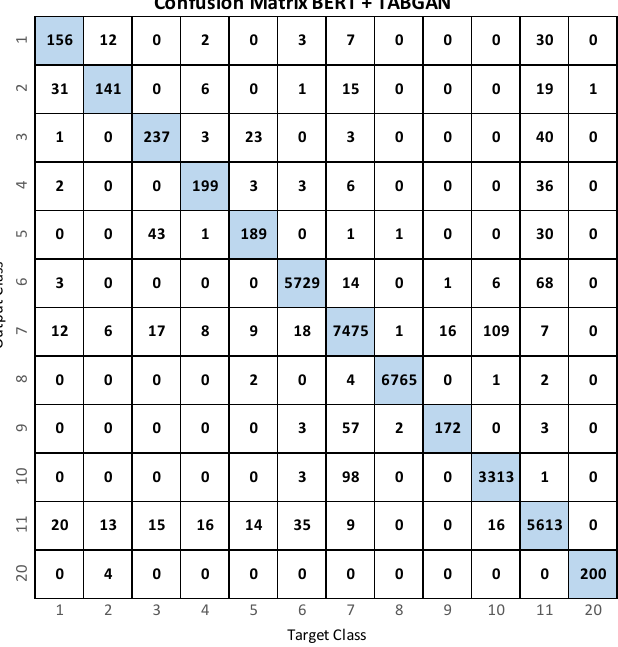
Figure 8. Confusion matrix for activity recognition with